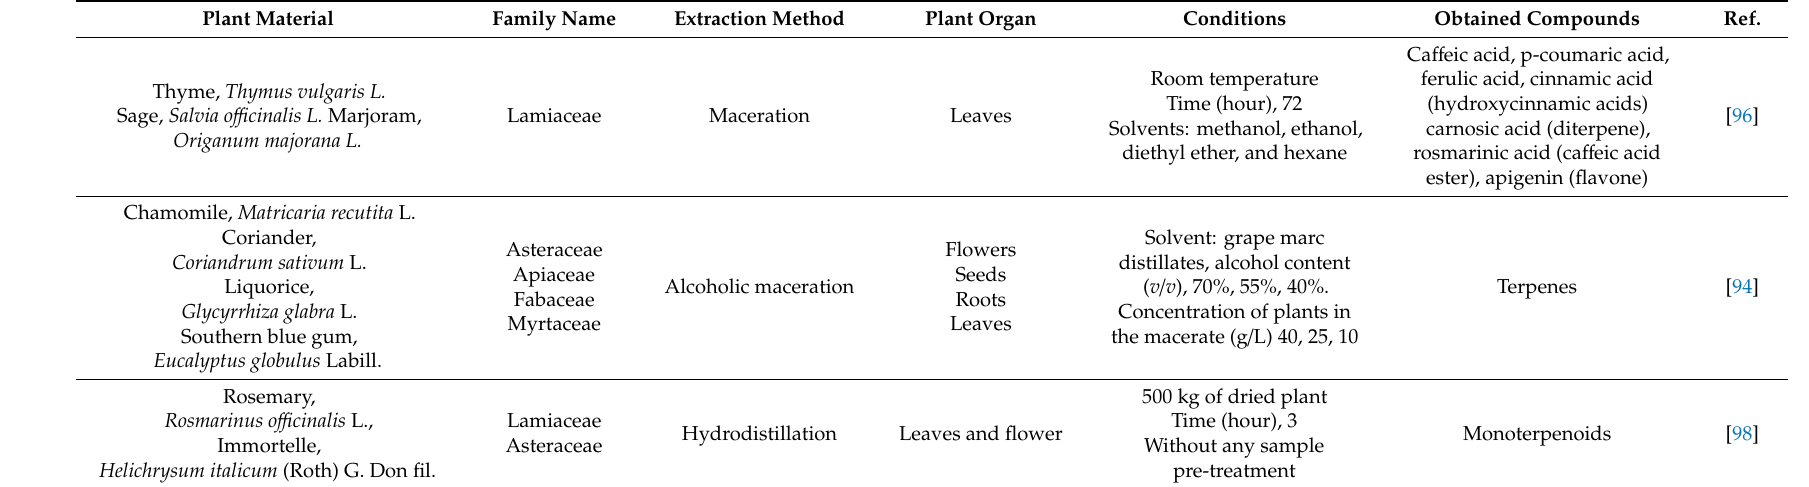
Table 3. Classical extraction methods applied to di ff erent plants materials and the obtained compounds (in chronological order of the cited